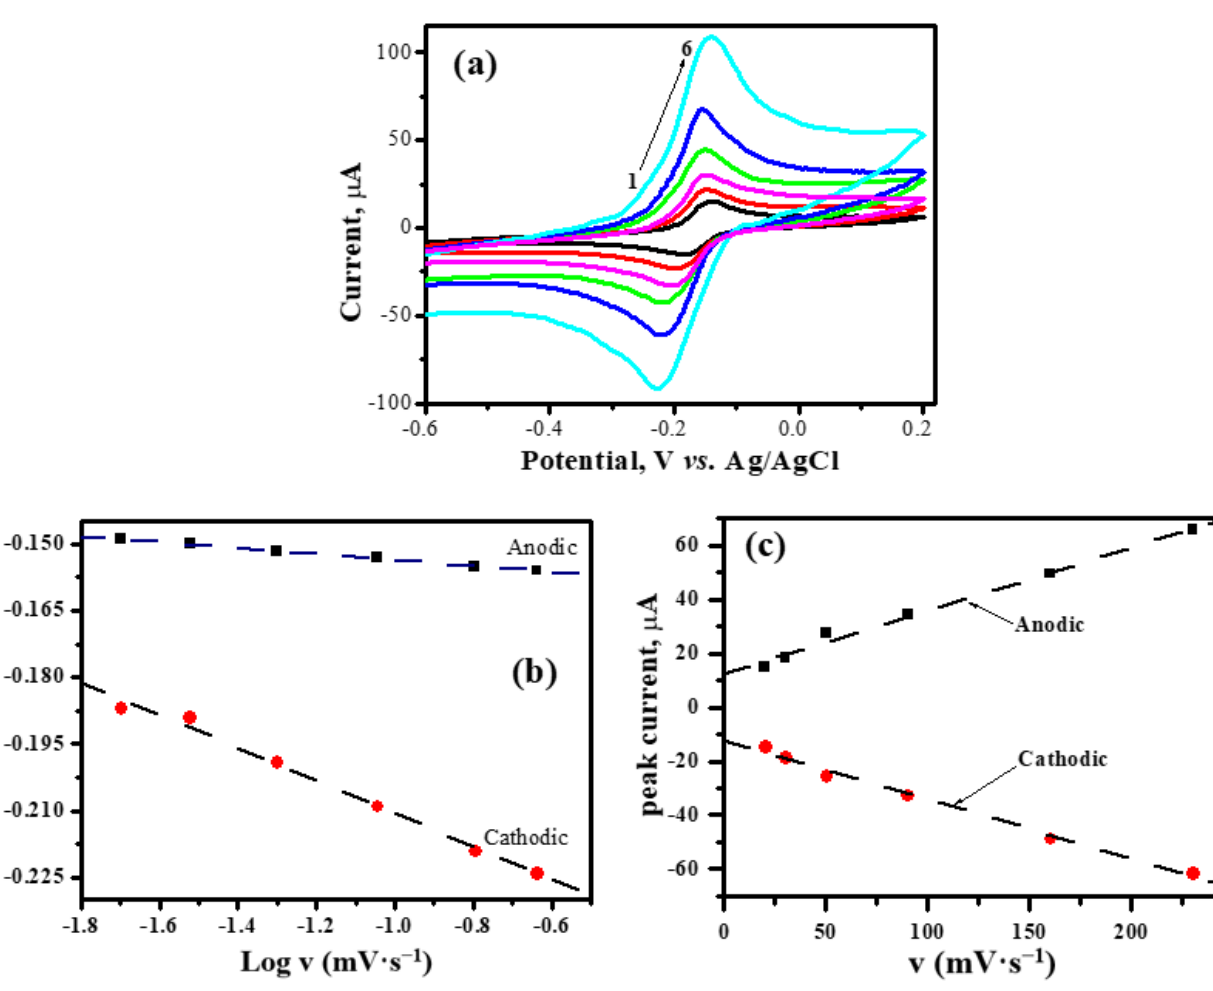
Figure 7. ( a ) Cyclic voltammograms recorded in 0.1 M PBS (at pH 8) + 1 mM TB at various scan rates: (1) 20, (2) 30, (3) 50, (4) 90, (5) 130 and (6) 230 mV s −1 , ( b ) Plot potential as a function of the logarithm of scan rate, ( c ) Plot of the anodic and cathodic peak currents as a function of scan rate recorded on GCE/Lys/HA.